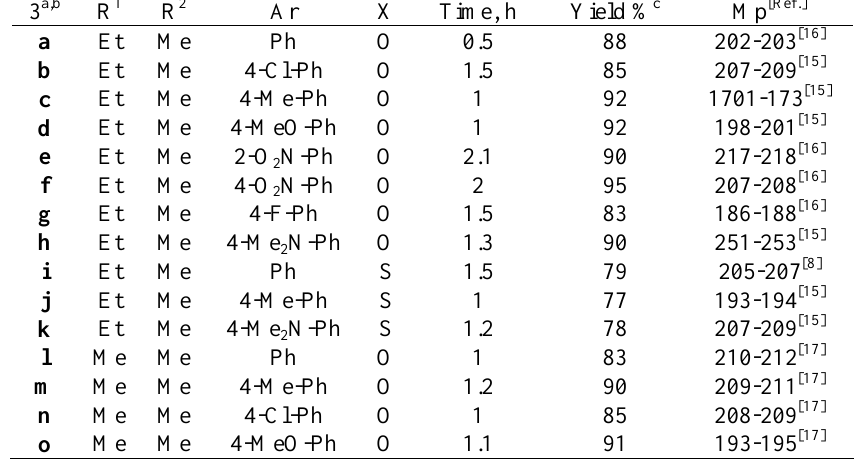
Table 1. Synthesis of 3,4-dihydropyrimidin-2(1 H )-ones and thiones ( 3a–q) in the presence of TFA